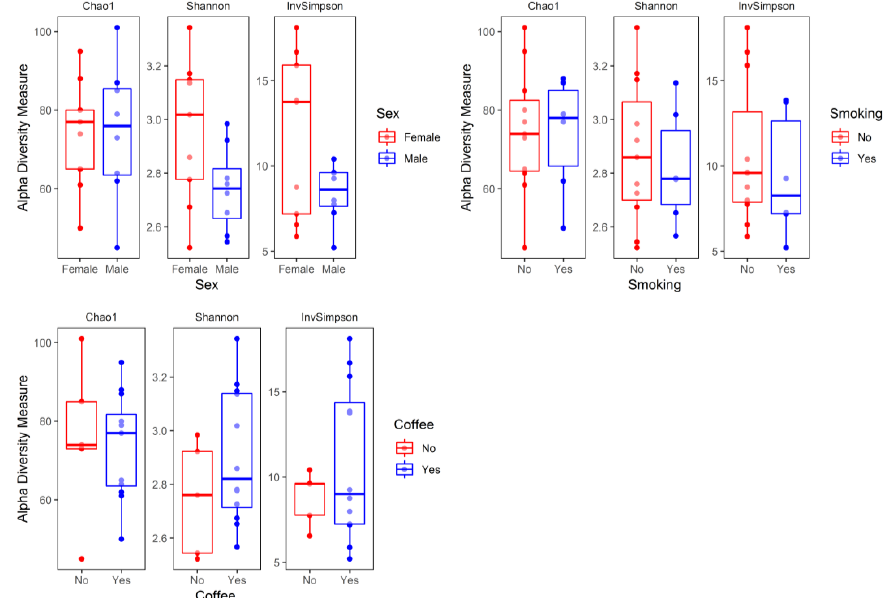
Figure 3. Alpha diversity metrics — Chao1, Shannon, and inverse Simpson (invSimpson) with respect to sample metadata (sex, smoking status, and coffee consumption) at baseline (W0). The boxplots represent diversity measures (center line — median, lower, and upper hinges correspond to the first (Q1) and third (Q3) quartiles; whiskers — the upper whisker is located at the smaller of the maximum alpha diversity measures and Q3 + 1.5 × IQR (Q3 − Q1); the lower whisker is located at the larger of the minimum alpha diversity measures and Q1 − 1.5 × IQR).